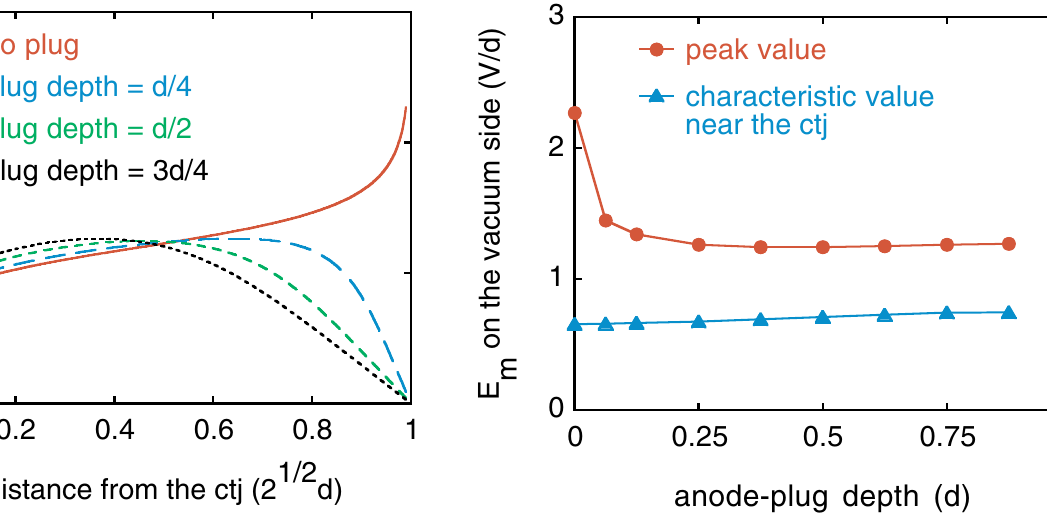
FIG. 9. (Color) The peak value of E on the vacuum side of an m idealized 2D 45 (cid:1) vacuum-insulator interface, as a function of anode-plug depth. The figure assumes that the dielectric constant of the insulator " (cid:8) 2 : 55 . (When the depth is equal to 0, we plot near the anode triple junction.) the characteristic value of E m near the cathode Also plotted is the characteristic value of E m triple junction. The fields are given in units of V=d , where V is the voltage across the insulator and d is the insulator thickness as defined by Fig. 1.